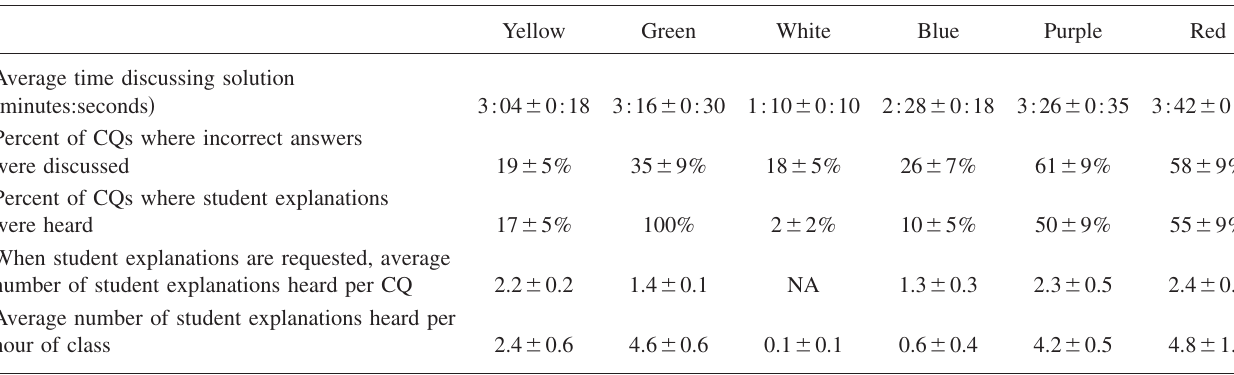
Yellow Green White Blue